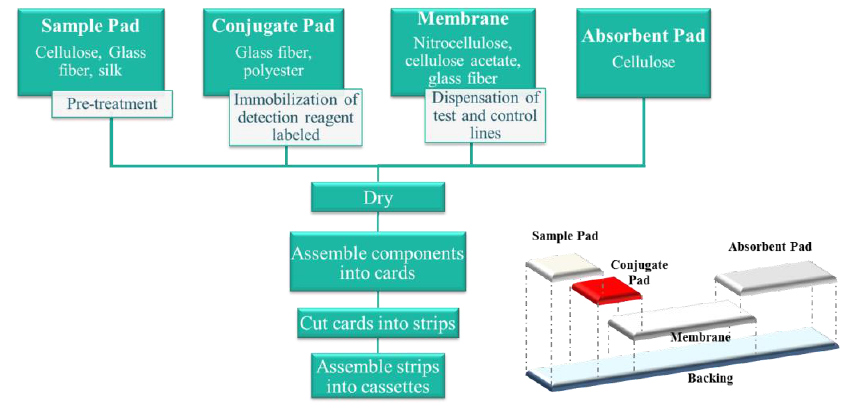
Figure 2. Outline of a lateral flow immunoassay manufacturing process. The materials and process typically required are detailed in the diagram. The bottom figure represents the assembling process.